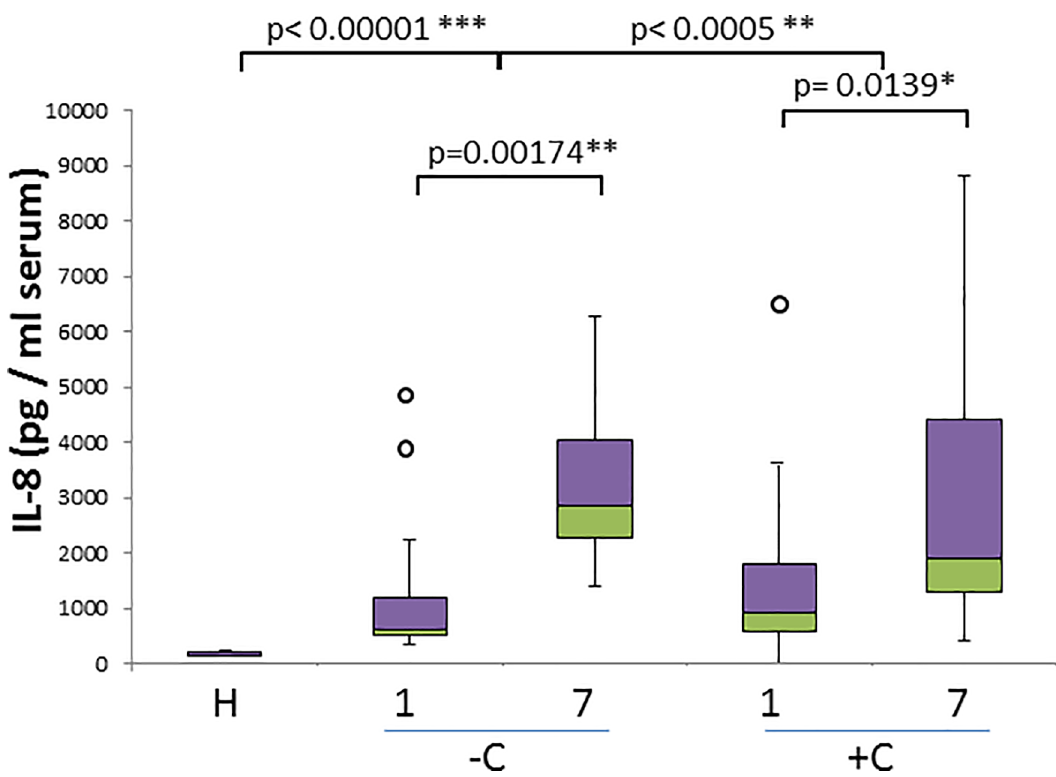
Fig 2. IL-8 concentration in healthy and naturally infected dogs and its relation with outcome. Box and whisker plot with outliers showinginterquartile range (medianbar in intersect betweentwo colors in box) of IL-8 concentration values amongdifferent groupsamong different groups: healthydogs (H), uncomplicated (-C) and complicated(+C) cases for both day 1 and day 7. Mann-whitney test p- values are shown for comparisonof different groups.